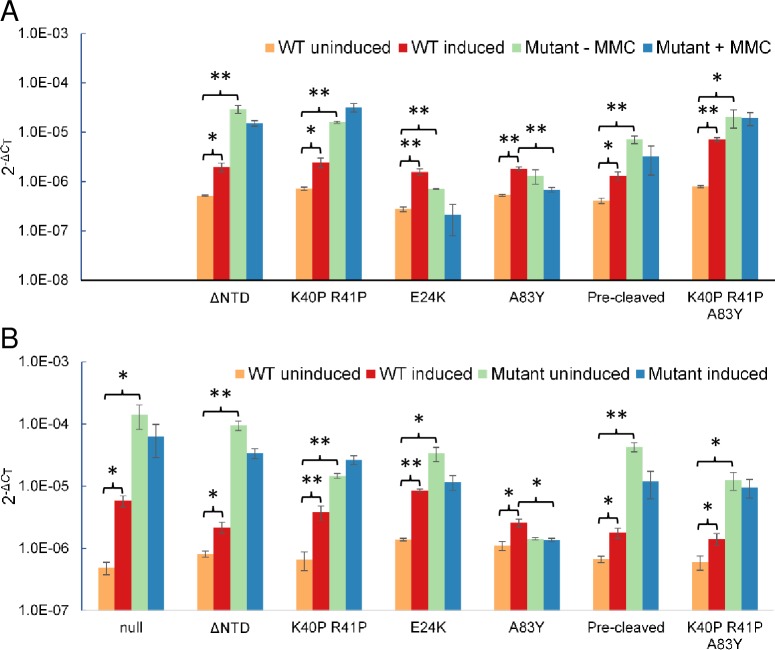
Regulation of DNA damage-inducible ddrR and umuDAb expression by UmuDAb requires NTD and CTD actions.RT-qPCR experiments measured gene expression, in the absence or presence of DNA damaging (2 μg/mL MMC) growth conditions, of (A) umuDAb (ACIAD2729) and (B) ddrR (ACIAD2730) in wild type ADP1 cells vs various umuDAb mutant strains). The specific type of mutant UmuDAb form is represented on the x-axes and comparable to each other in vertical alignment. Each gene was assayed in one RT-qPCR experiment (plate), with error bars indicating standard error of the mean from technical triplicates of biological triplicates. Statistical significance in a Student’s t-test is indicated by the symbol * for p values < 0.05, and by the symbol ** for p values < 0.01.